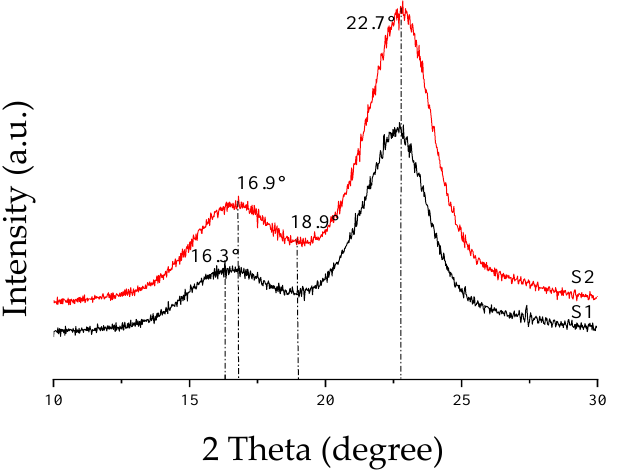
Figure 6. XRD patterns of corn straw: S1 corn straw, S2 corn straw after silica solution treatment.